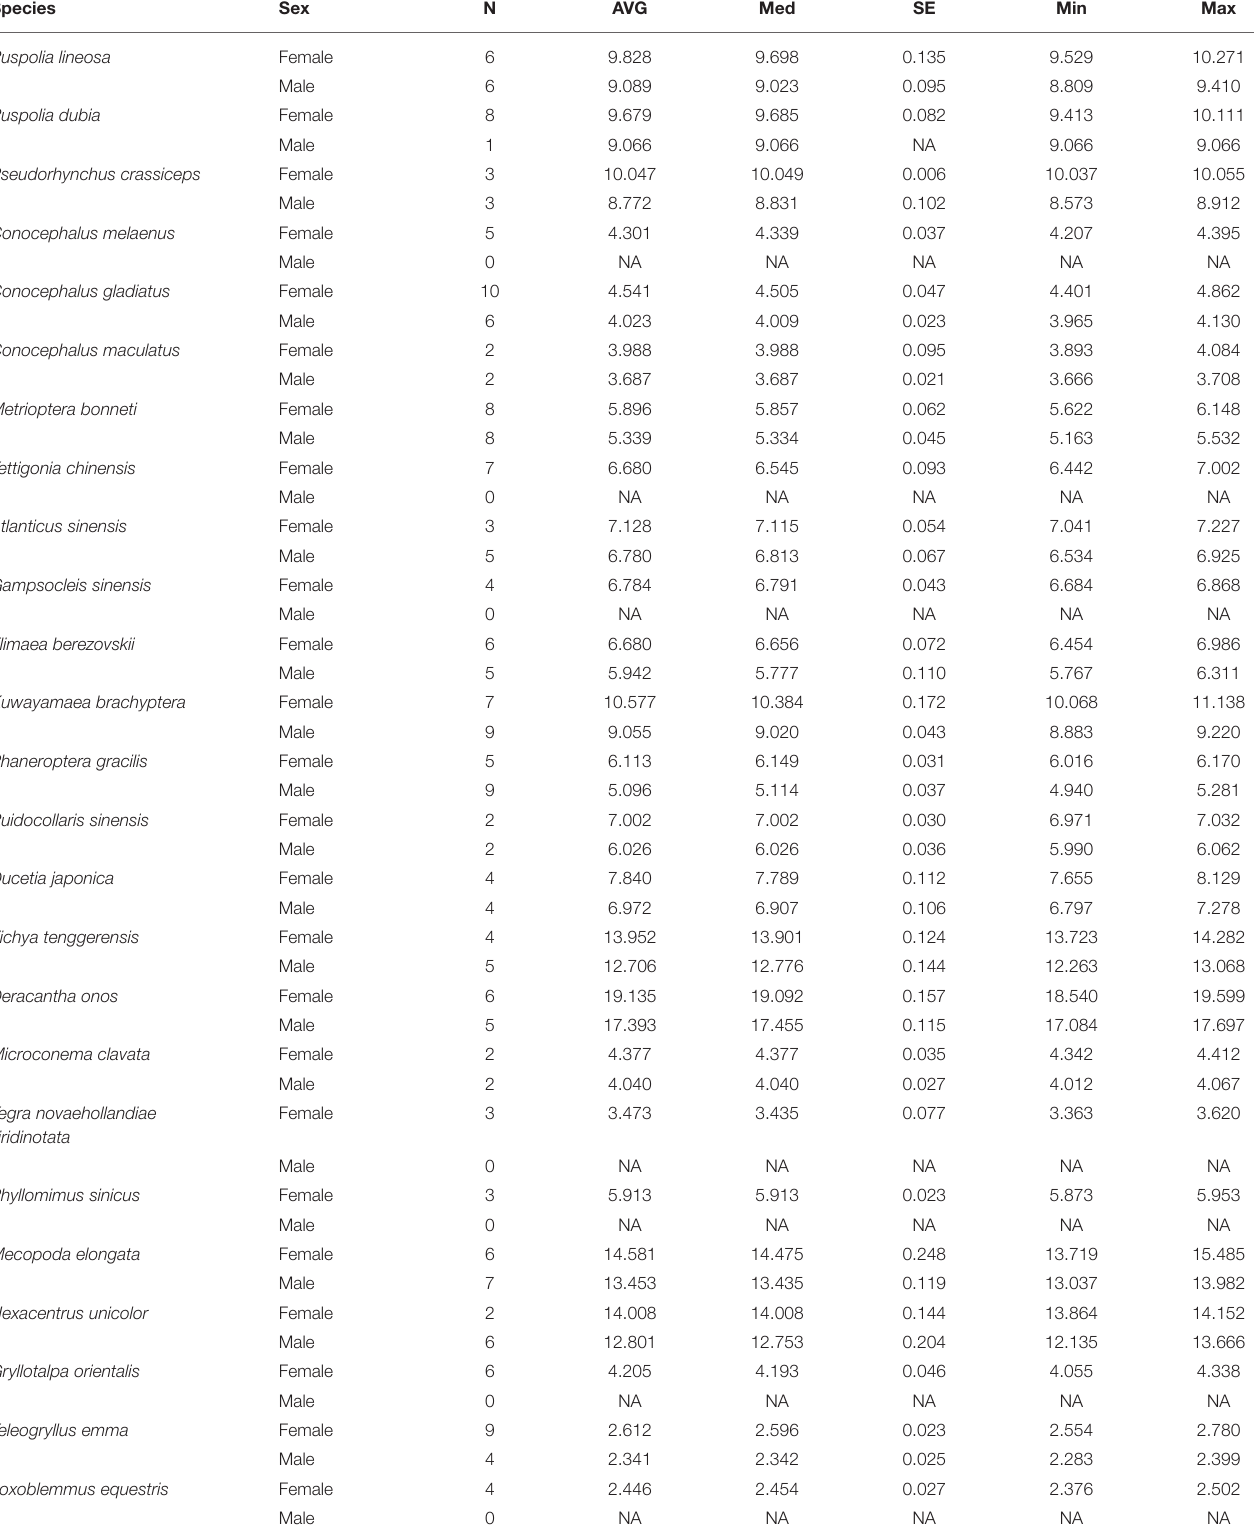
TABLE 1 | Genome sizes (pg) of males and females of 32 Ensifera species, determined using flow cytometry.